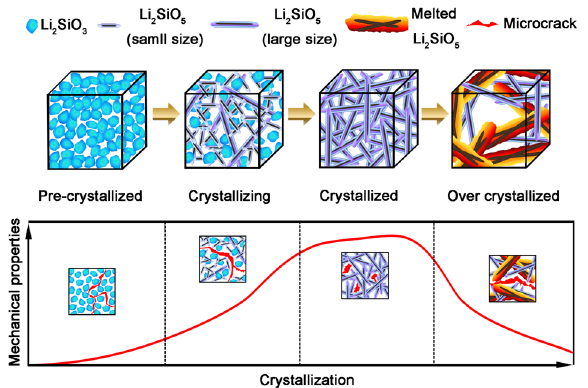
Fig. 8 Schematic of microstructural and mechanical evolution of LDGC materials during thermal processing. The gap between LM grains, small size LD grains and melted LD grains facilitates the propagation of microcrack, thus the mechanical properties of LDGC were decreased. However, dense interlocking structure con fi nes the areas of